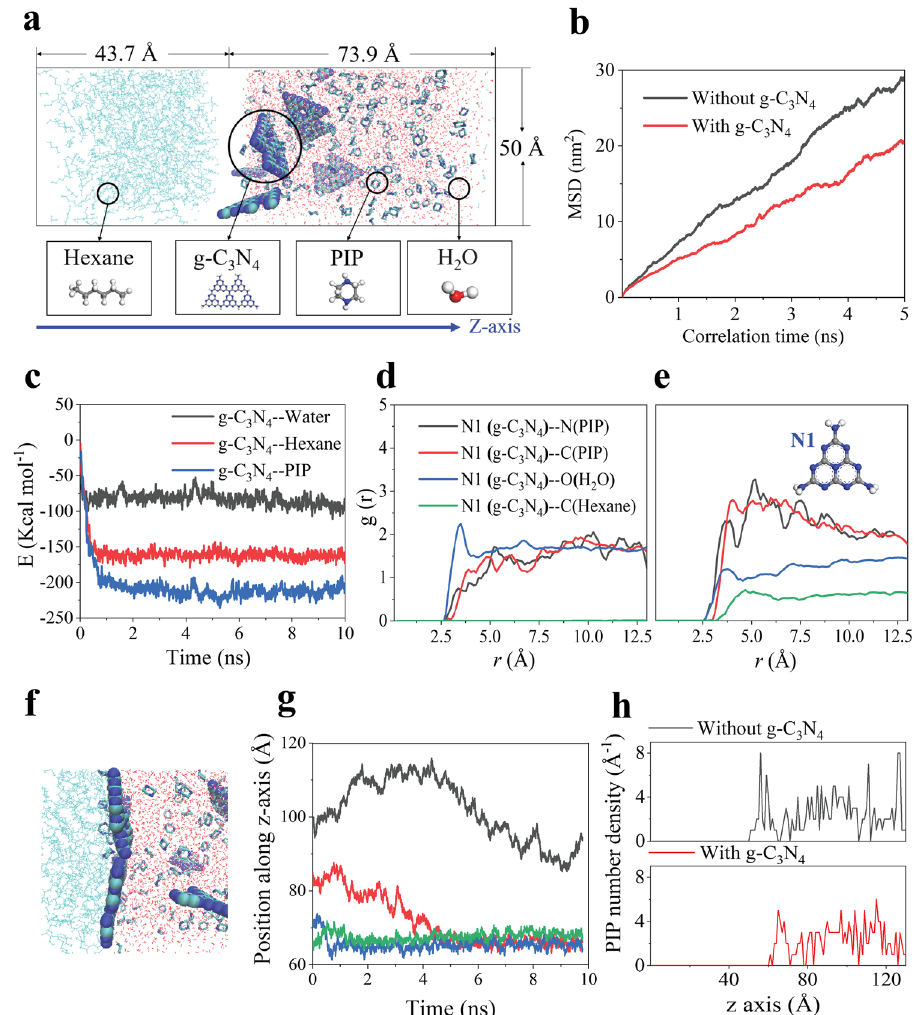
Fig. 2 | Molecular dynamics simulation of the interfacial polymerization pro- cess.a Simulationmodels:theleftchambercontainshexaneandtherightchamber is fi lled with water, PIP molecules, and g-C 3 N 4 ; a similar model without g-C 3 N 4 was also constructed as control. b Time dependence of MSD curves of PIP molecules. c Interaction energy between g-C 3 N 4 and other species calculated by model B (see Methods). d The RDF of N1 atoms in g-C 3 N 4 around PIP (N, C), water (O), and n-hexane(C)atthestartofthesimulation. e TheRDFofN1atomsing-C 3 N 4 around